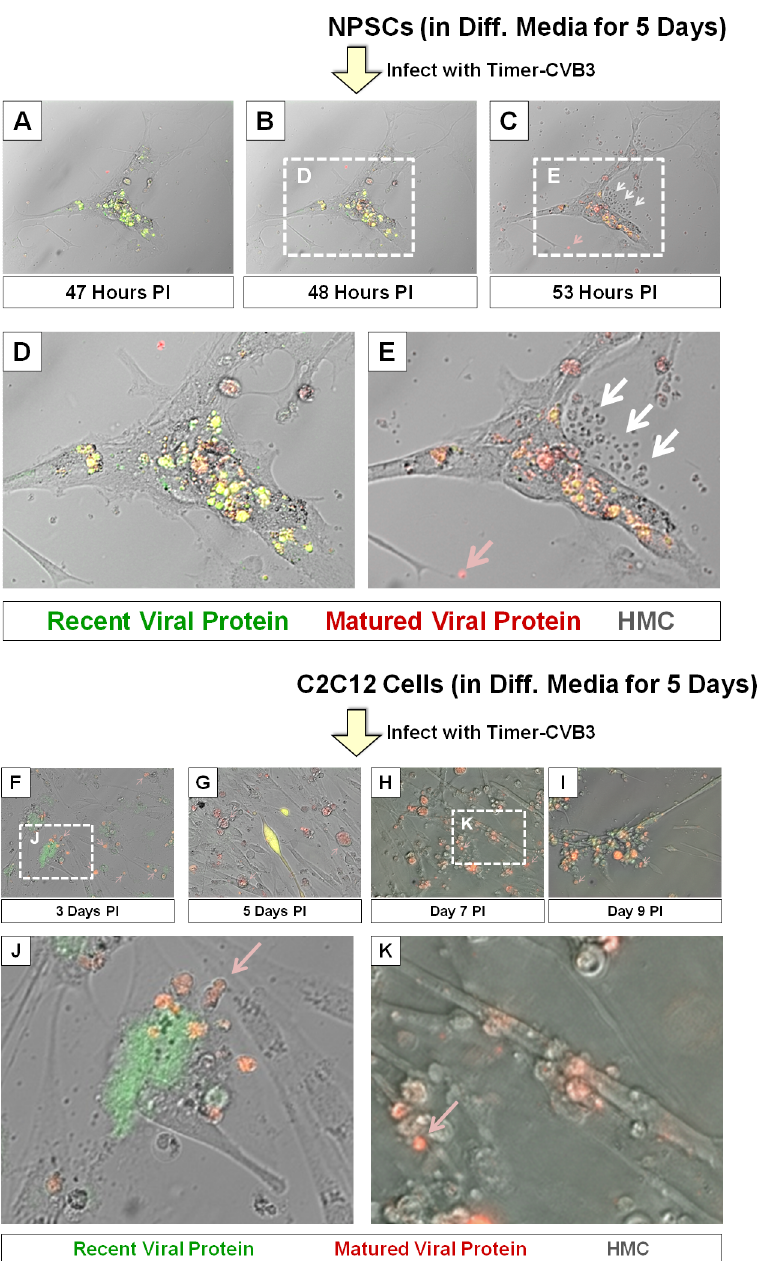
Figure 7. Shedding of EMVs containing viral protein following Timer-CVB3 infection of differentiated cells. (A–C) ‘‘Fluorescent timer’’ protein changed from green to red over the span of 6 hours in differentiated NPSCs infected with Timer-CVB3. (D) , (E) Digital magnification of (B) and (C) , respectively, revealed the shedding of EMVs (white arrows) some containing matured ‘‘fluorescent timer’’ protein (pink arrow) between 48 and 53 hours post infection. (F–I) Abundant EMVs containing matured ‘‘fluorescent timer’’ protein were observed in differentiated C2C12 myoblast cells infected with Timer-CVB3. (J) Digital magnification demonstrated the presence of EMVs containing matured ‘‘fluorescent timer’’ protein (pink arrow) near recently-infected cells in green at 3 days PI. (K) By 7 days PI, EMVs containing matured ‘‘fluorescent timer’’ protein (pink arrow) were observed near cells with signs of cytopathic effects.